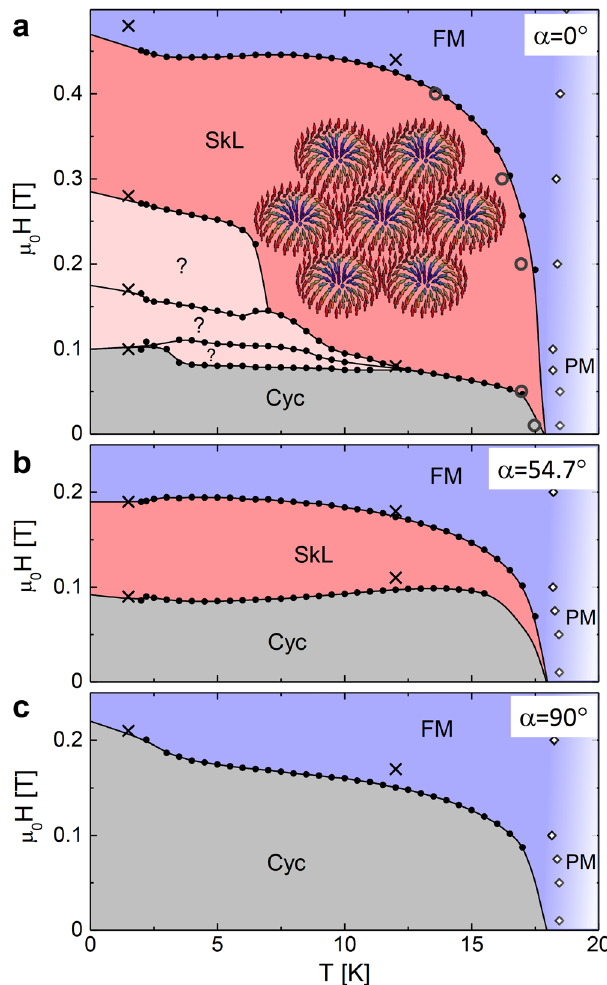
Figure 1. Extended cycloidal and Néel-type SkL states in GaV 4 Se 8 . ( a ) Magnetic phase diagram for magnetic fields parallel to the polar axis, α = 0°. Below T C = 18 K, the cycloidal (Cyc) and SkL phases, underlying the field polarized ferromagnetic state (FM), persist down to the lowest temperatures. The Néel-type SkL spin texture is schematically illustrated. Phase boundaries are assigned to anomalies in ∂ M / ∂ H versus H (closed circles) and ∂ M / ∂ T versus T (open circles) curves and by the SANS data (crosses). Lines are guides to the eye. The crossover region between the paramagnetic (PM) and FM states is indicated by open diamonds and color gradation. Below 12 K additional phases, labeled by question marks, emerge between the cycloidal and SkL states. ( b ) Magnetic phase diagram for fields applied at α = 54.7° with respect to the polar axis. In the phase labeled as Cyc, the magnetic field component normal to the polar axis continuously distorts the cycloid into a tilted conical structure, as visualized in Fig. 4g. The field component along the polar axis still establishes the SkL before the FM is reached. ( c ) For magnetic fields applied perpendicular to the polar axis, α = 90°, the Cyc state corresponds to the regular cycloid, which is smoothly canted by the field to form a transverse conical structure, as sketched in Fig. 4e, and eventually transforms into the